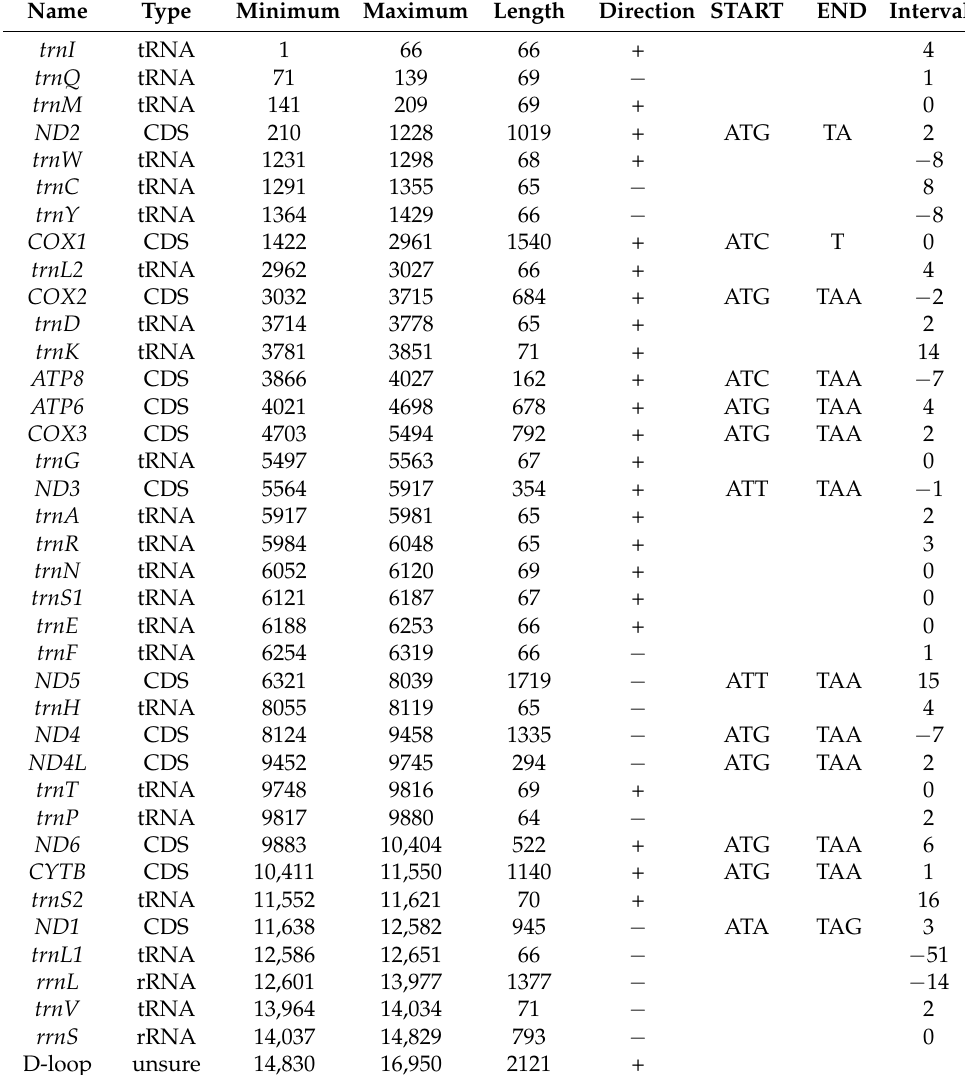
Table 3. Annotation of the complete mitogenome of Alulacris shilinensis